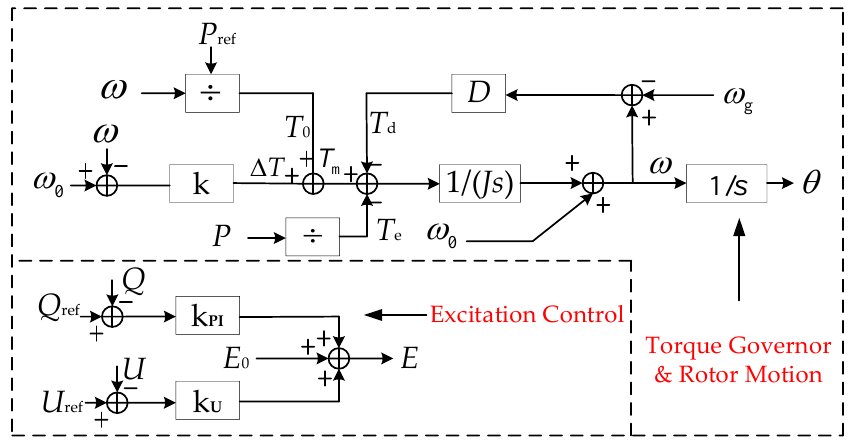
Figure 5. Control chart of virtual synchronous generator. As shown in Figure 5, the active power controller adjusts the active power through adjusting the torque of the VSG turbine regulator according to the value difference between the actual power and the expected power. Moreover, the reactive power controller adjusts the VSG excitation and bridge arm voltages to adjust the reactive power. The active power is fed back to the control link in the form of torque. Then the synchronous angular velocity ω is obtained so the output synchronous angle is θ after the integration. Inertia and damping parameters are introduced to simulate the characteristic of the synchronous generator to keep the stability of the frequency and power under the